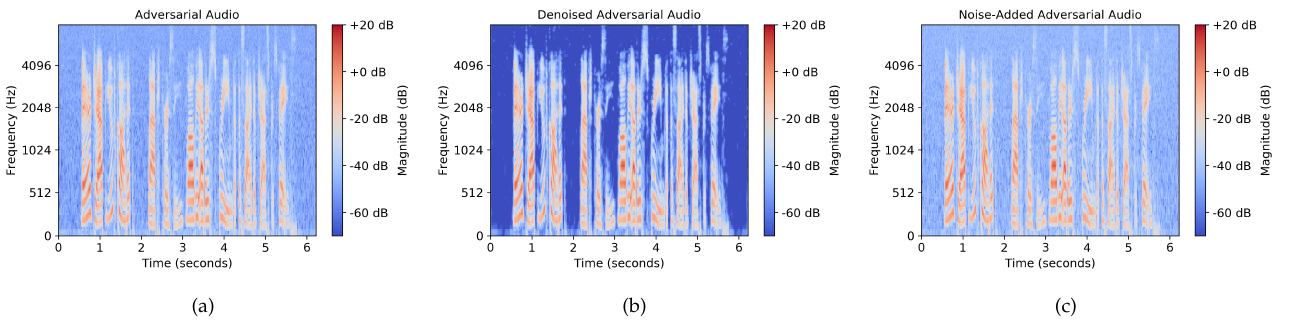
Figure 5. The mel spectrograms of an adversarial audio, a denoised adversarial audio, and a noise- added adversarial audio. ( a ) Adversarial audio; ( b ) denoised adversarial audio; ( c ) noise-added adversarial